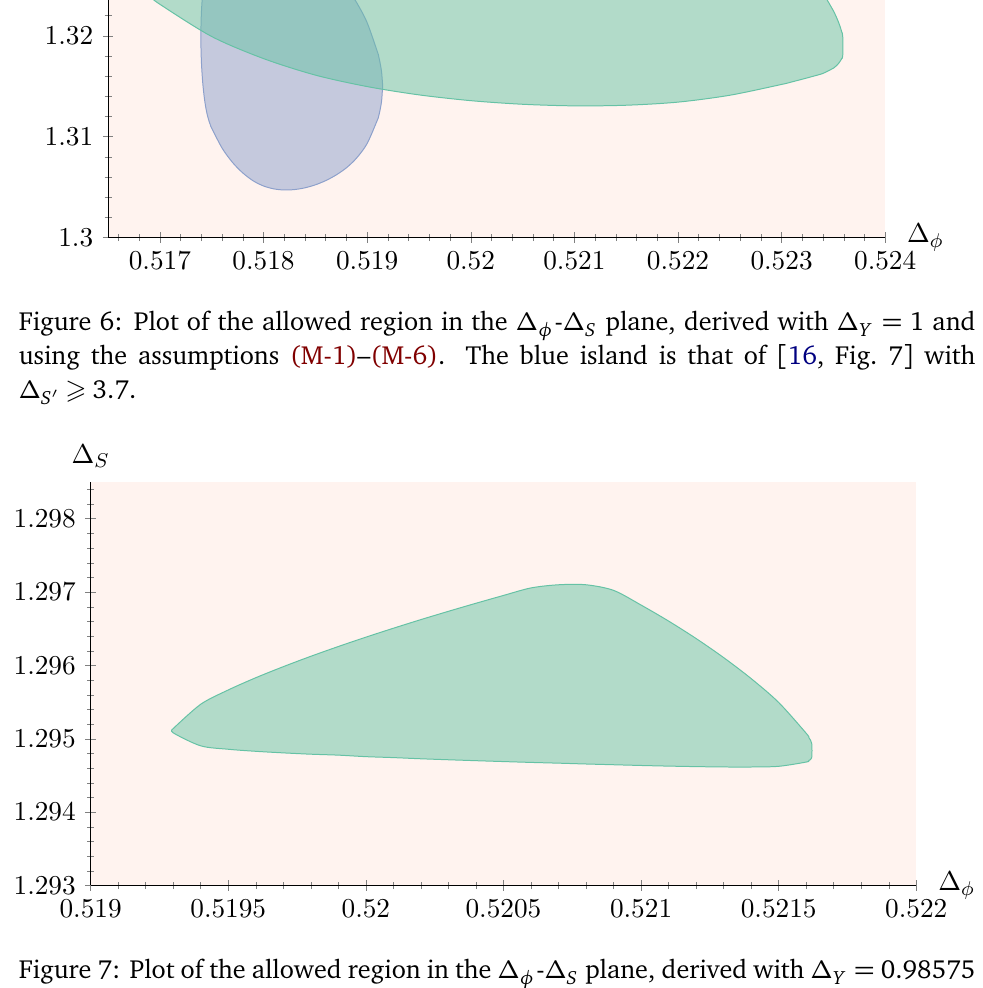
Figure 7: Plot of the allowed region in the ∆ φ - ∆ and using the assumptions (M-1)–(M-6)